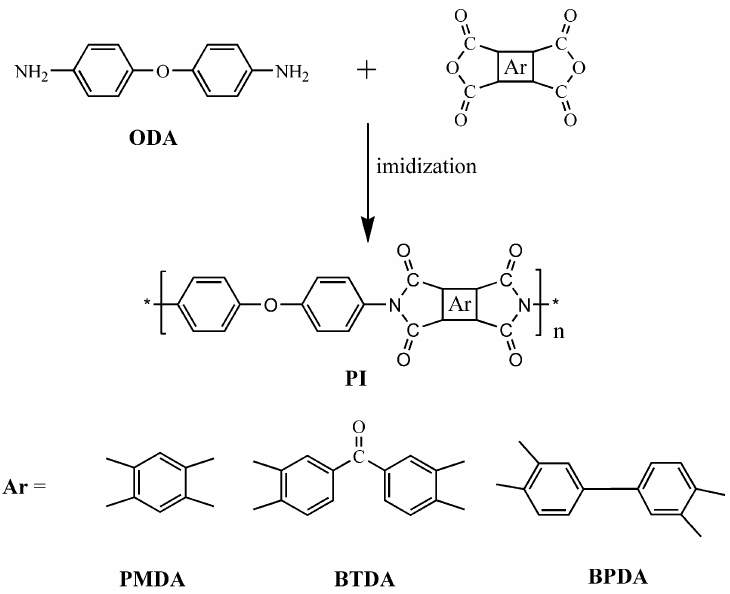
Figure 1. Synthesis process of polyimide (PI) films. ODA = 4,4’-diaminodiphenyl ether; PMDA = pyromellitic dianhydride; BTDA = 3,3’,4,4’-benzophenonetetracarboxylic dianhydride.